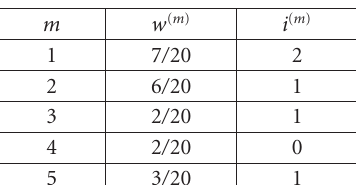
Table 1: Weights of particles.